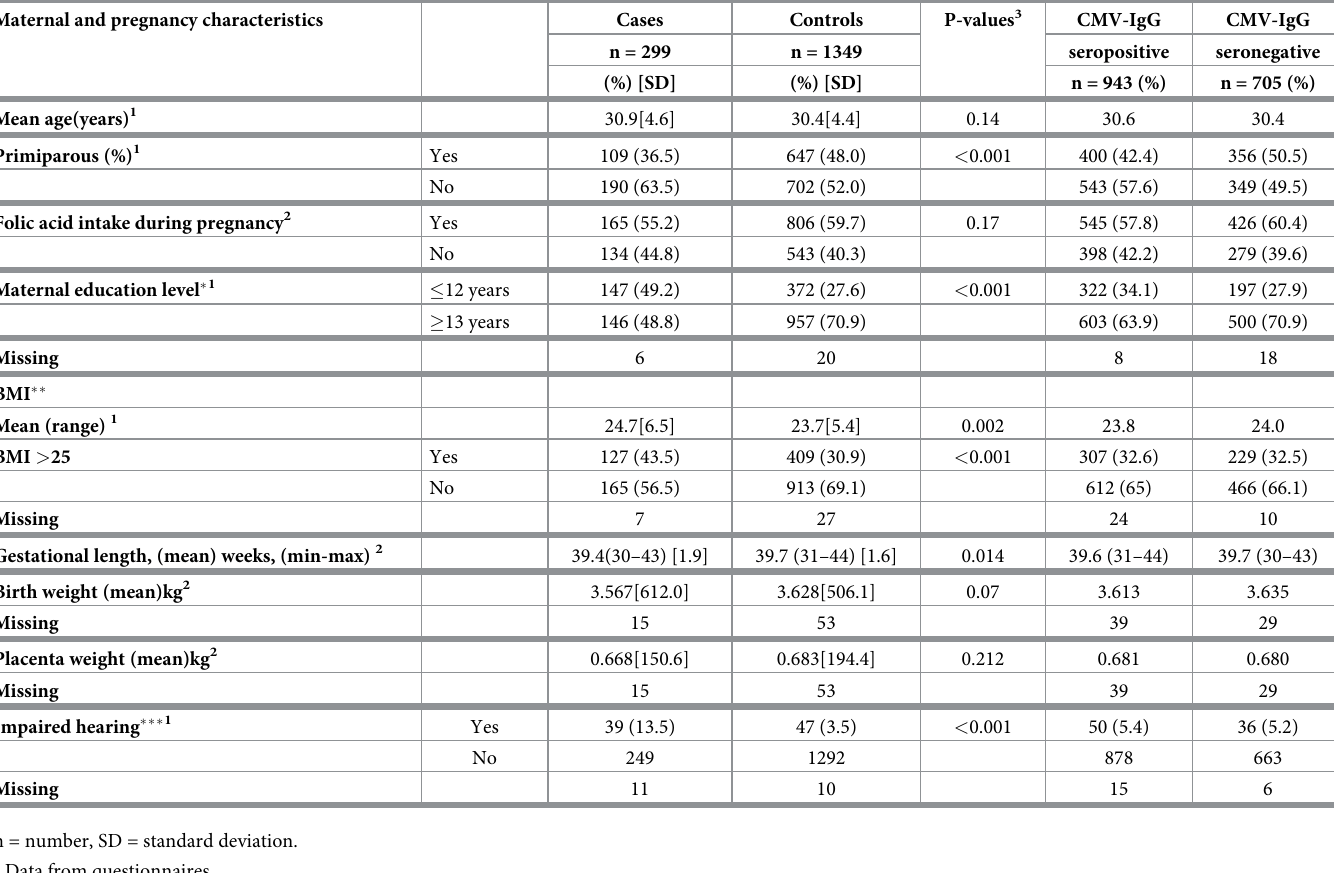
Table 3. Maternal and pregnancy characteristics in 299 delayed language delay cases and 1349 population based controls from the Norwegian Mother, Father and Child Cohort Study (MoBa). Maternal and pregnancy